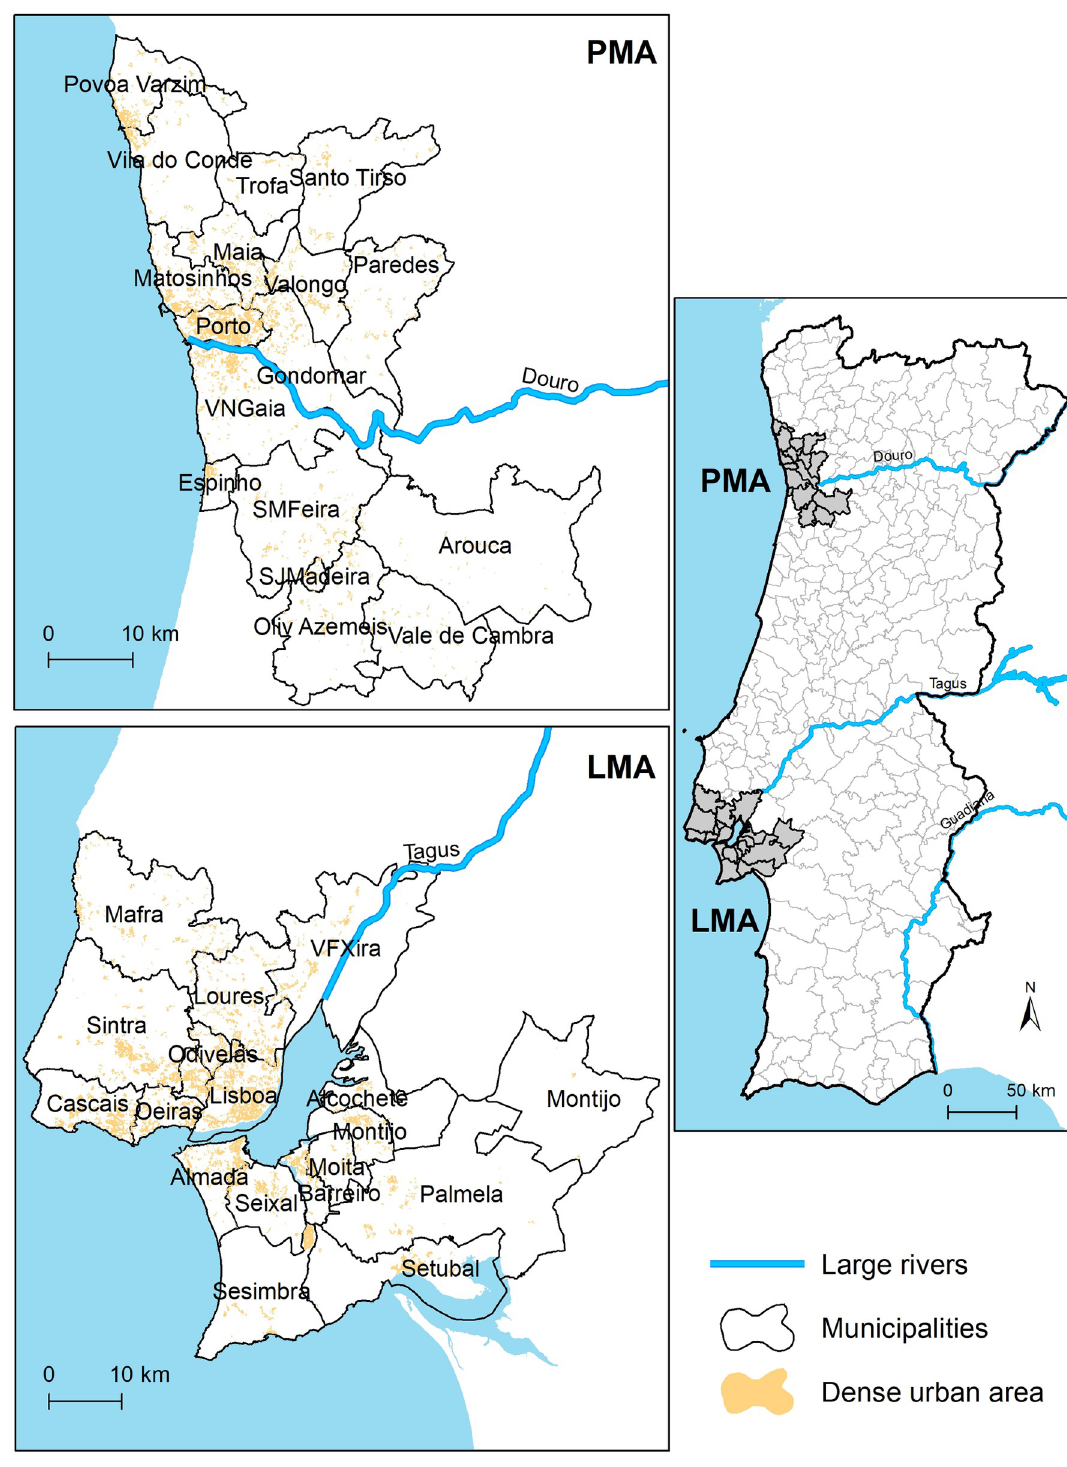
Fig 1. Location of the two metropolitan areas of Portugal (LMA–Lisbon, PMA–Porto), with the distribution of the dense urban areas within their territory.